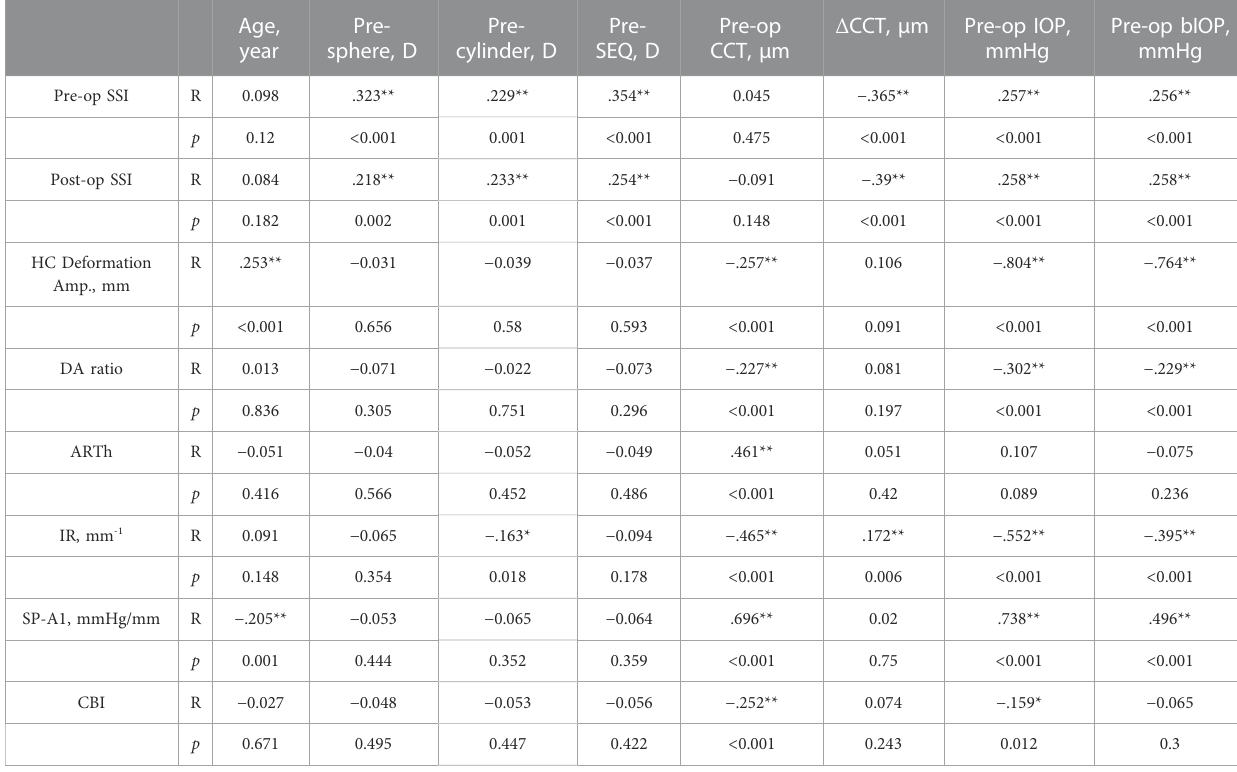
TABLE 3 Pearson ’ s or Spearman ’ s correlation analysis of the factors related to stress-strain index values and other biomechanical parameters.